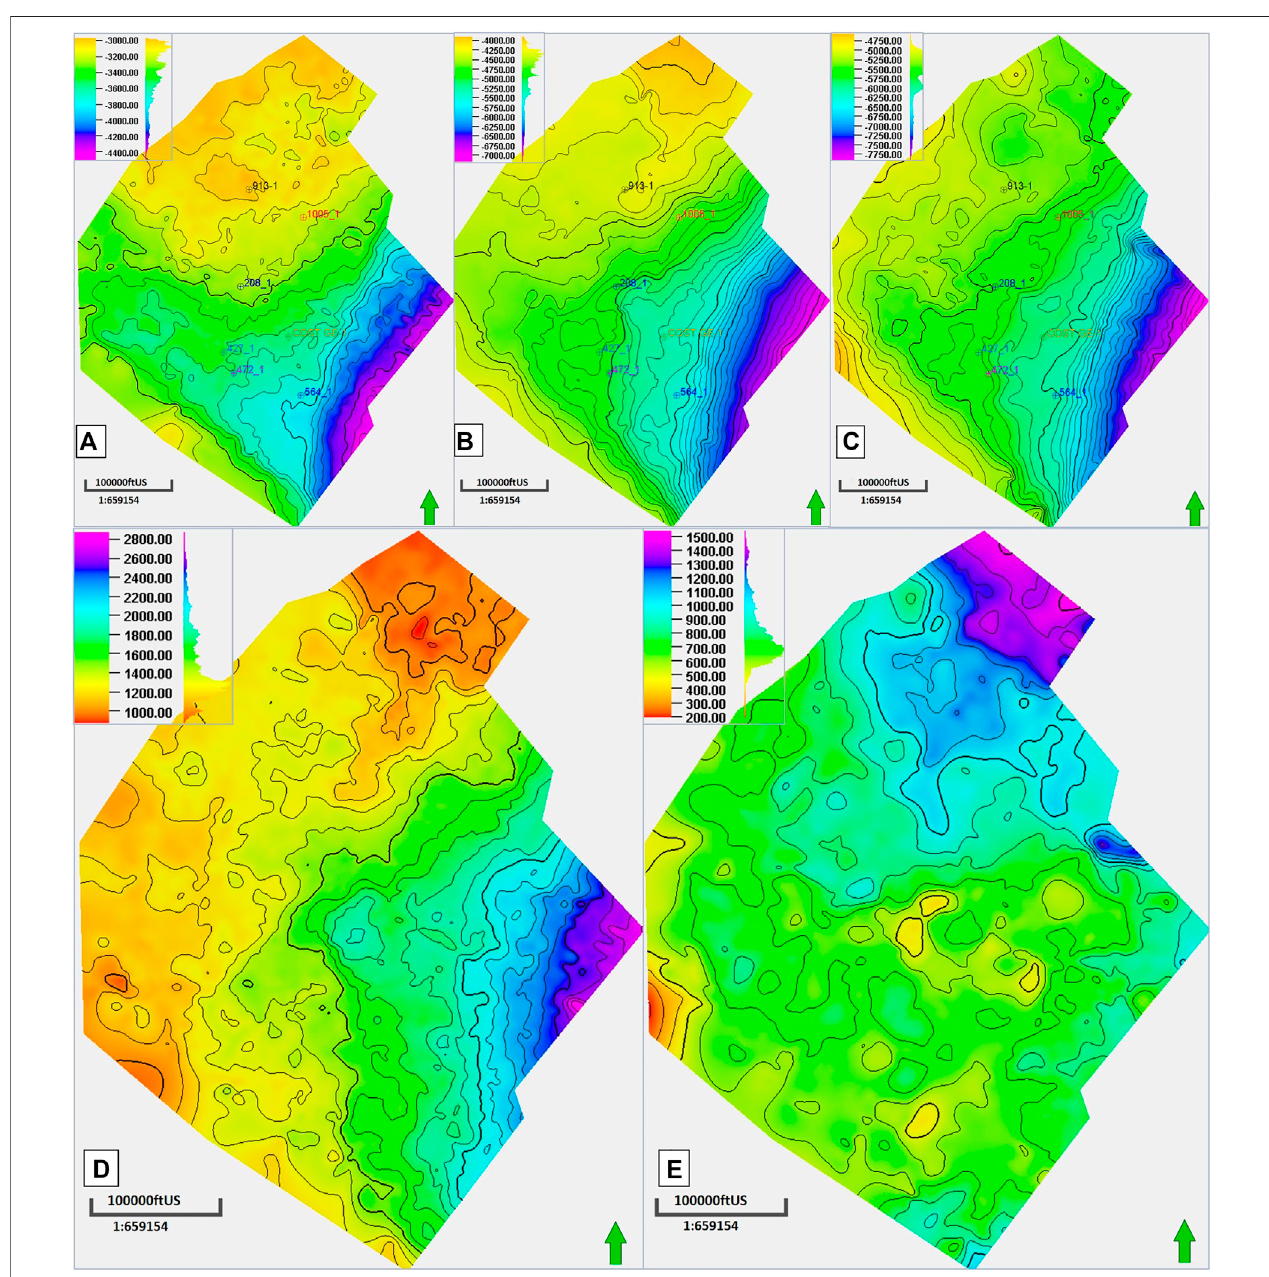
FIGURE 15 | Structure maps, in feet, for (A) top of Upper Cretaceous (Late Maastrichtian), (B) Turonian, and (C) base of Upper Cretaceous (Albian). Thickness maps (isochore) in feet for (D) prospective seal and (E) potential reservoir within the offshore of Southeast Georgia Basin (Almutairi et al., 2017).